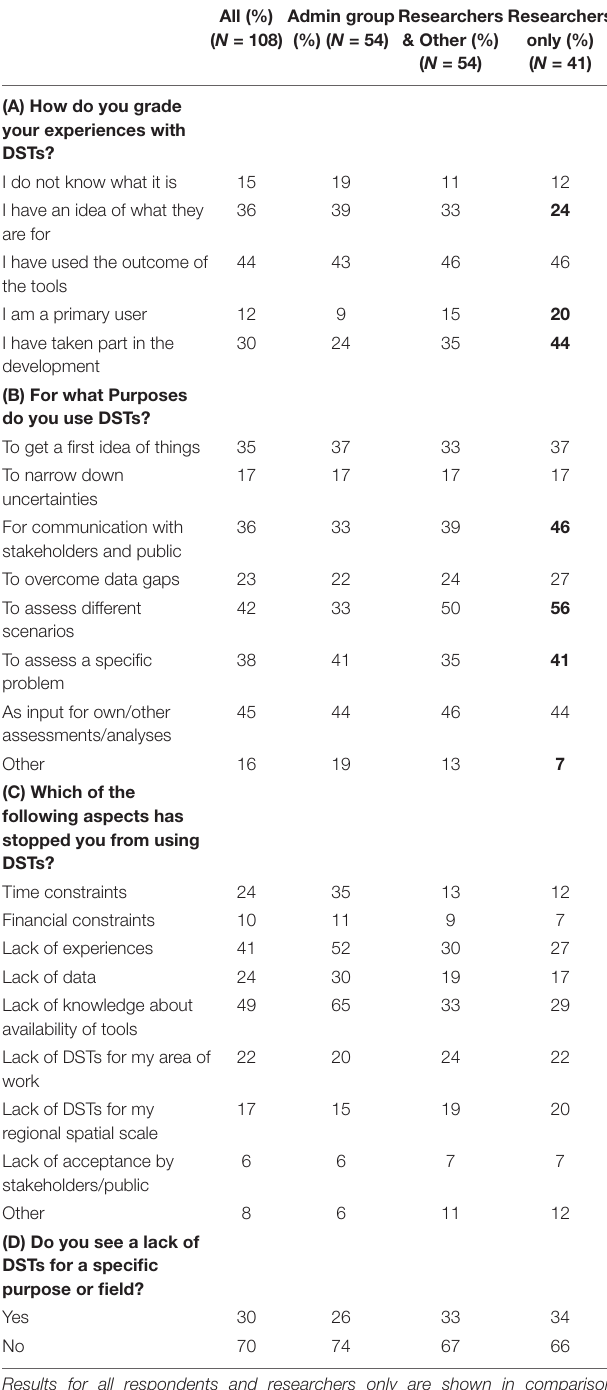
TABLE 2 | Results of the stocktaking questionnaire shown separately for the respondents working in administration (Admin group, Group A) and all other respondents (Researchers and Others, Group